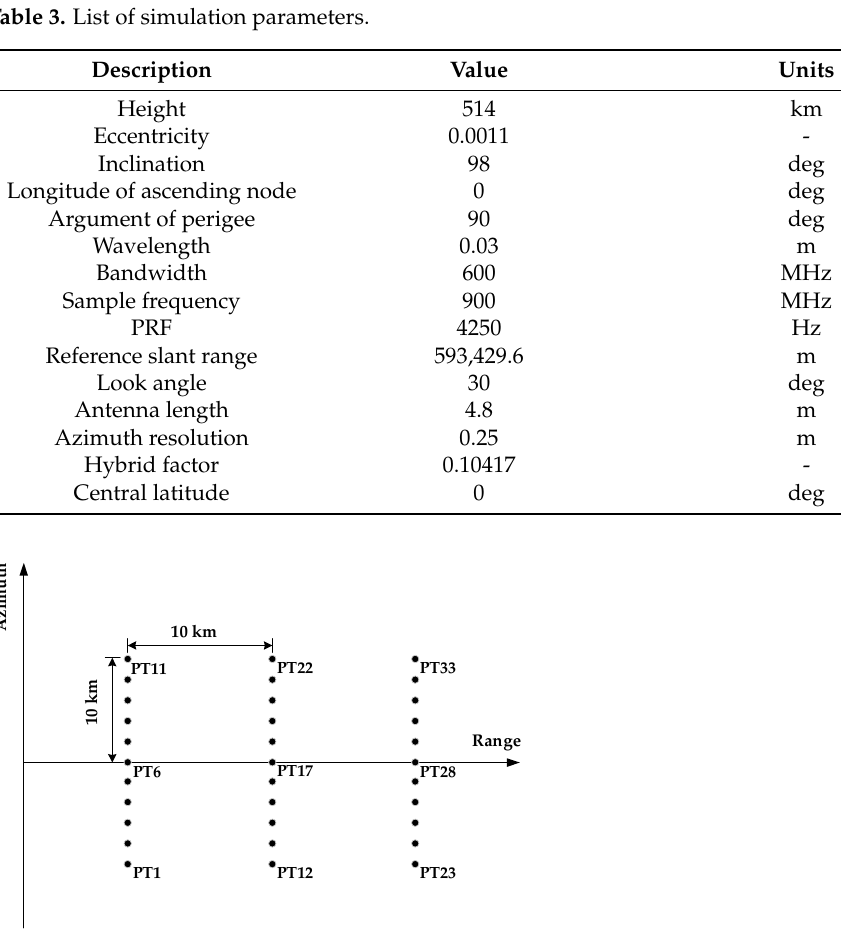
Figure 8. Ground scene layout of the point targets in the simulation. Table 3. List of simulation parameters.